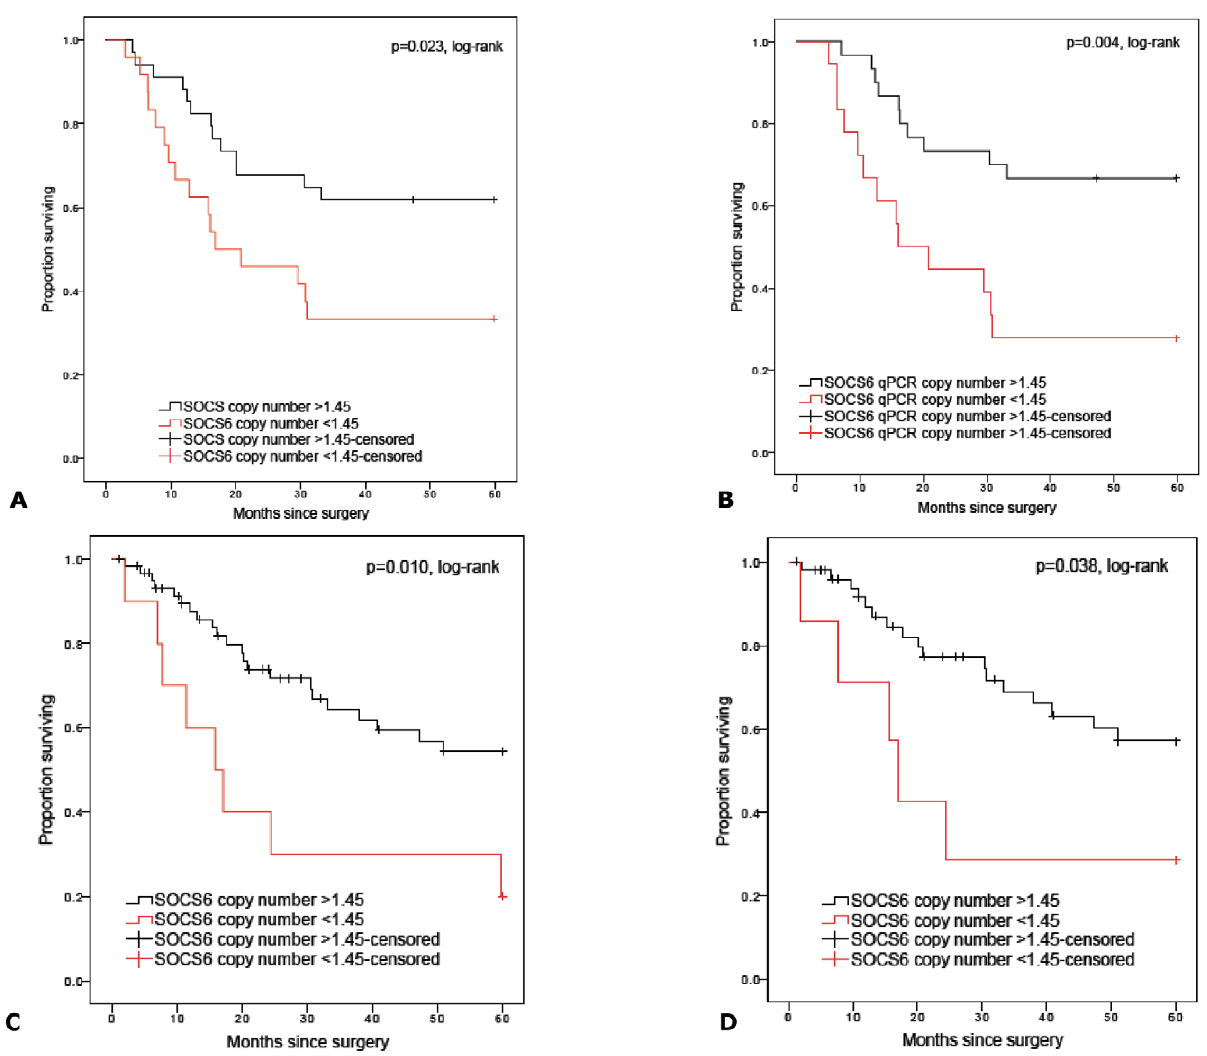
Figure 6. Kaplan-Meier curves of overall survival and SOCS6 qPCR-derived copy number in study subjects with follow-up duration of 5 years after surgical resection in the training set (n=62) and test set (n=72). Figure 6A and 6B represent overall survival in all training set and TNM early stage subjects while 6C and 6D represent all test set and TNM early stage test set subjects. Censored values ( + ) indicate the last known follow-up time for those subjects still alive after surgical